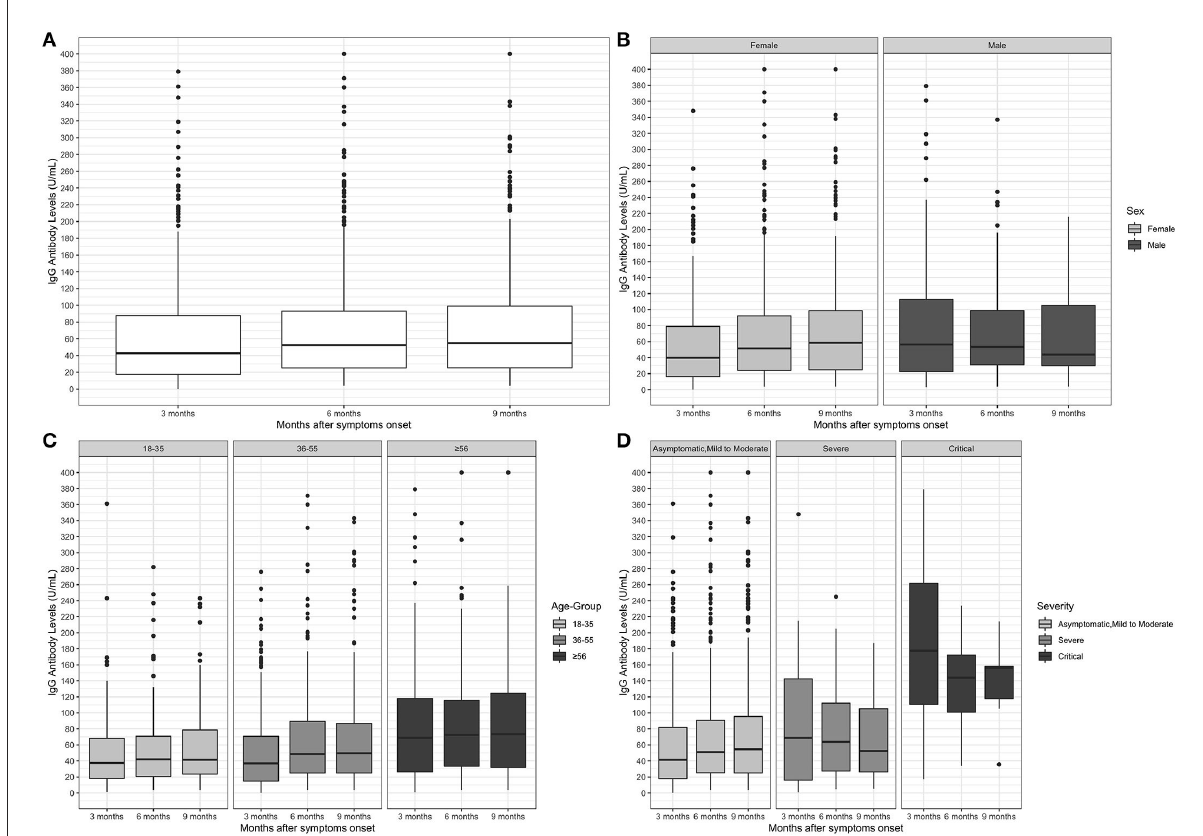
FIGURE2 Antibody levels at each considered time-point. (A) total, (B) stratified by gender, (C) stratified by age-group; (D) stratified by disease severity. (A) The median IgG antibody level was 42.8 (IQR, 17.7–87.8) 3 months after symptom onset, 52.4 (IQR, 25.4–93.0) and 54.9 (IQR, 25.4–98.9) in the 6th and 9th months after symptom onset. (B) At the first time-point (three months), the IgG antibody levels were significantly higher in men compared to women ( p = 0.003); for the remaining time-points, six ( p = 0.776) and nine ( p = 0.232) months, no significant differences were found. (C) The IgG antibody levels were significantly higher in the age group 56 years in the three time periods considered, compared to the age groups 18–35 ( p ≤ 0.001; p ≤ 0.001; p = 0.005) and 36–55 ( p ≤ 0.001; p ≤ 0.001; p = 0.005). (D) The IgG antibody levels were significantly higher in the critical severity level in the three time periods considered, compared to the asymptomatic, mild to moderate ( p = 0.003; p ≤ 0.001; p = 0.005) and severe levels ( p = 0.020; p = 0.008; p =